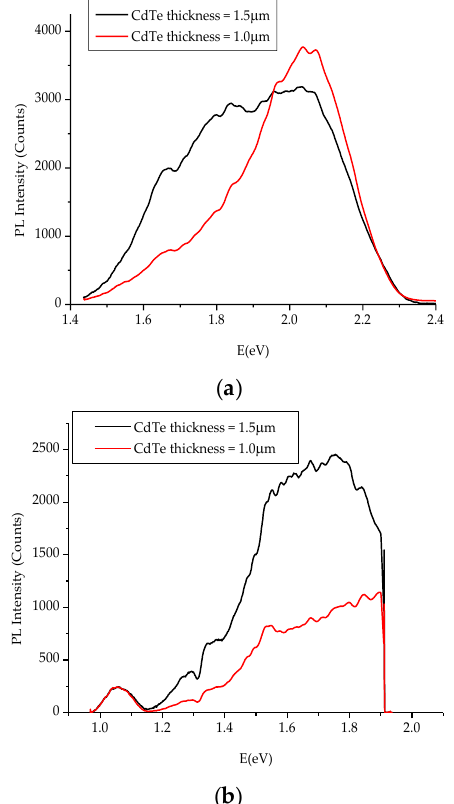
Figure 15. The photoluminescence spectra of the interface of CdS/CdTe solar cells. ( a ) taken by the second grating; ( b ) taken by the first grating [43].